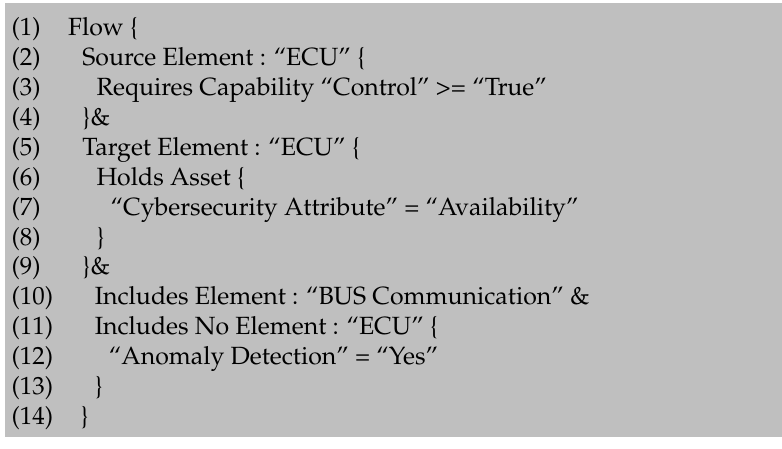
Figure A4. Anti-Pattern for Rule